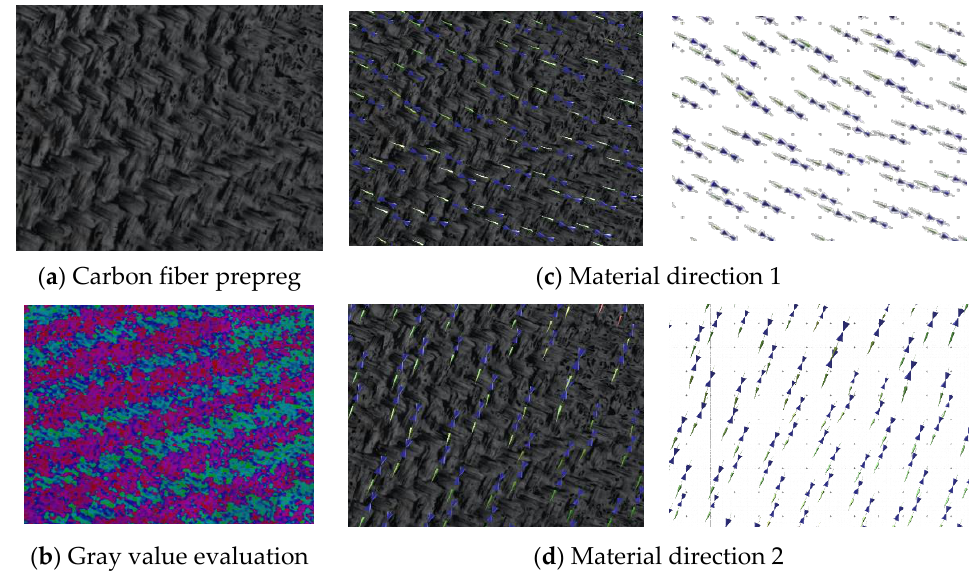
Figure 8 . Evaluation of the gray value distribution and assignment of material directions.